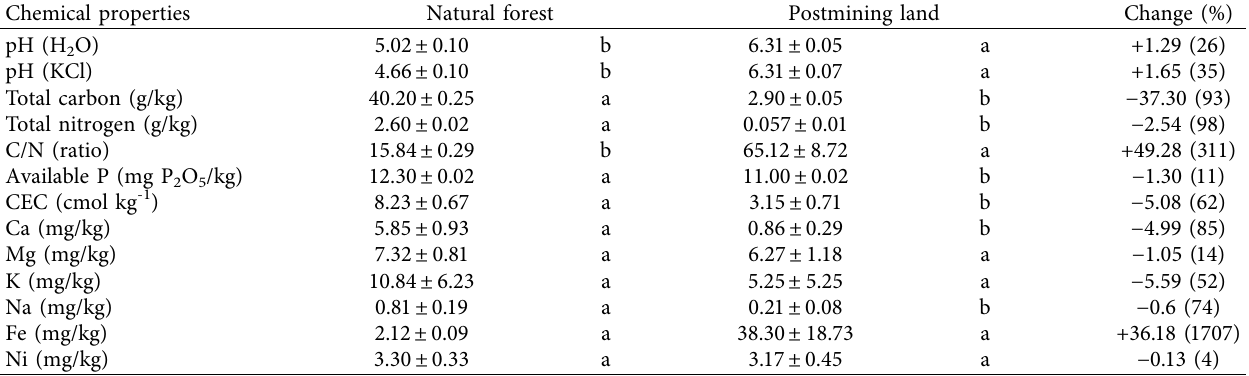
Table 1: Chemical properties of soils from natural forest and post-nickel mining land. Different letters within row indicate significant difference ( P < 0 . 05) by t -test. Mean ± standard error are shown ( n � 15). Chemical properties Natural